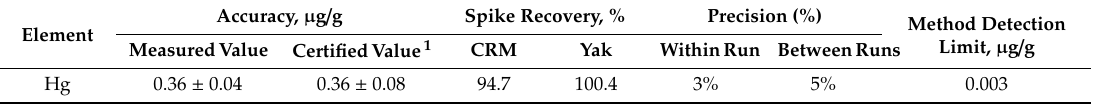
Table 3. Analytical characteristics of